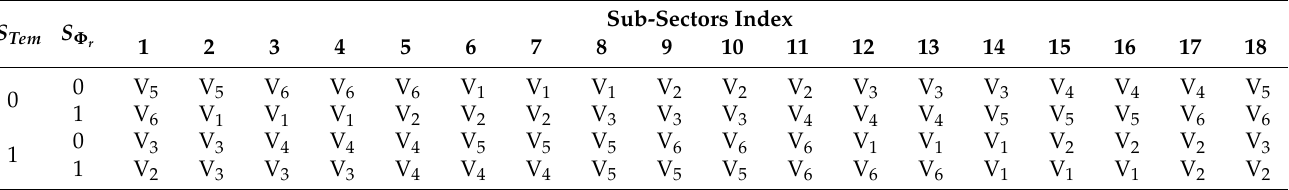
Table 3. The LUT of the proposed strategy for (18) SSs.